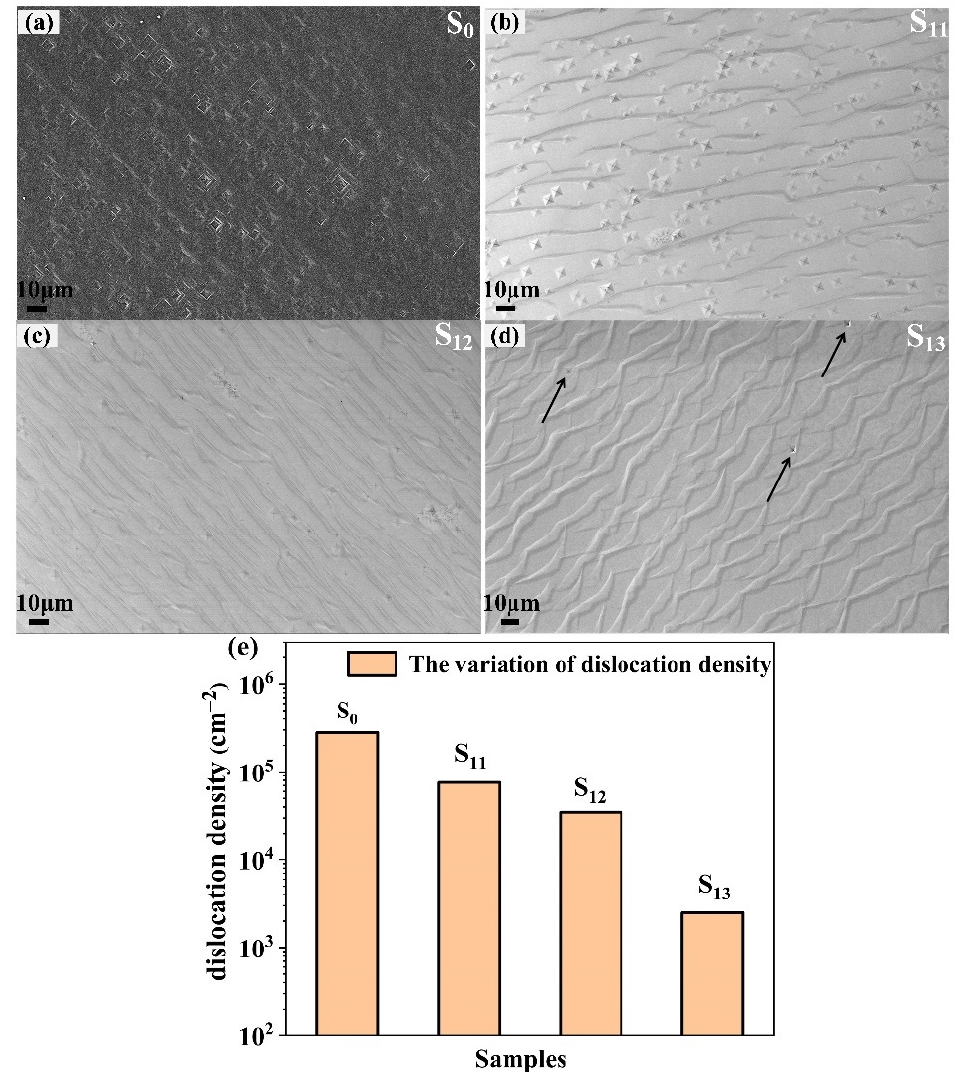
Figure 2. SEM images of four etched samples. ( a ) S 0 ; ( b ) S 11 ; ( c ) S 12 ; ( d ) S 13 ; ( e ) the variation of dislocation density in four samples.